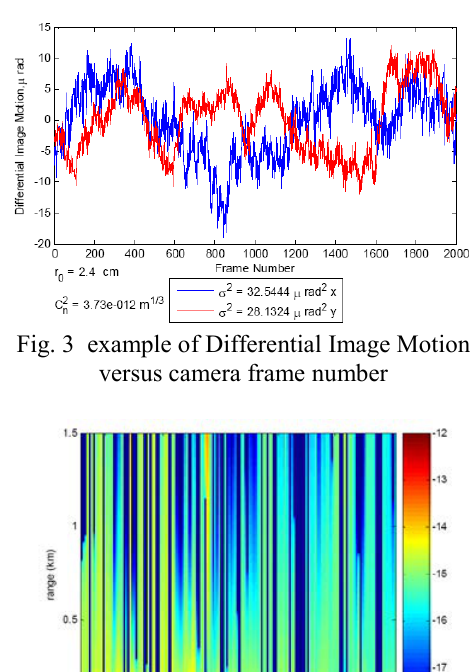
Fig. 4 Time-height diagram of the log